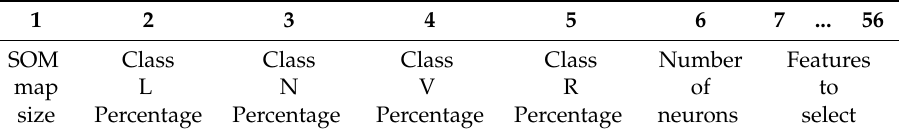
Table 4. Representation vector. Abbreviations: SOM: self organizing map.